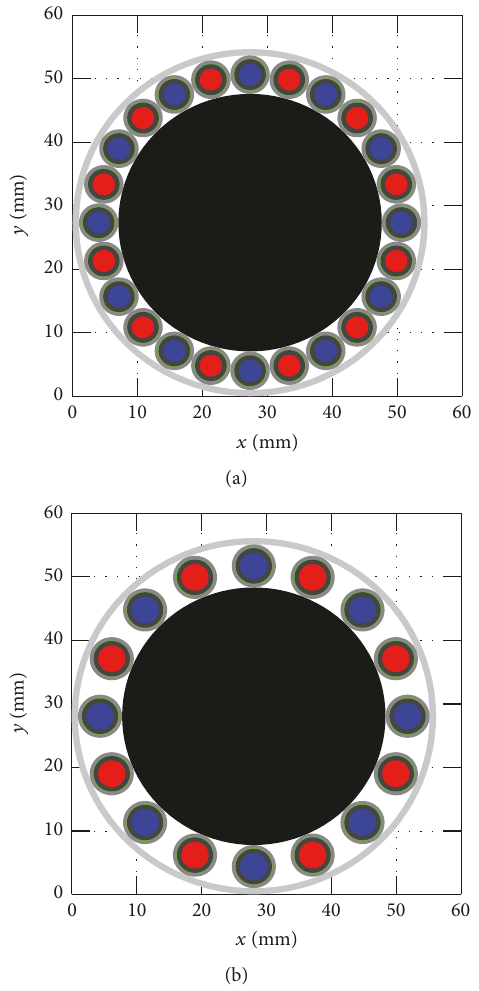
Figure 10: Tether cross section visualization with color coding as in Figure 8, with the parameters in Appendix A and Table 1 and with = 𝑛 = 24 and (b) 𝑛 = 16 electrical (a) 𝑛 c c , opt c